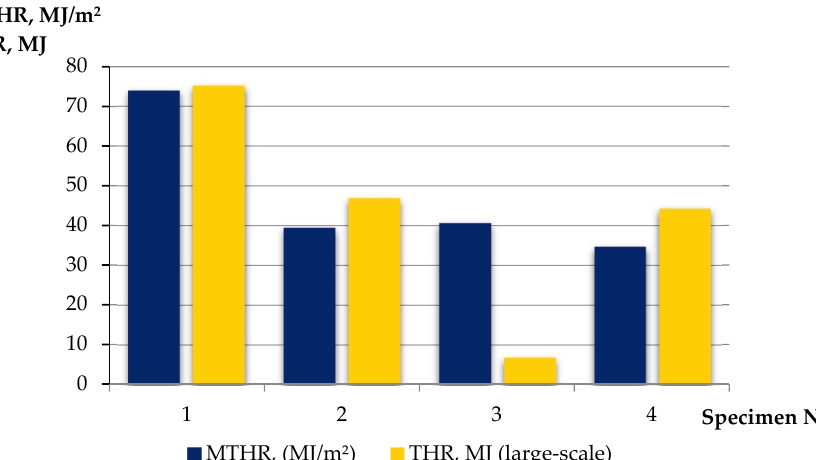
Figure 13. Comparison of MTHR and THR results for four tested cables.